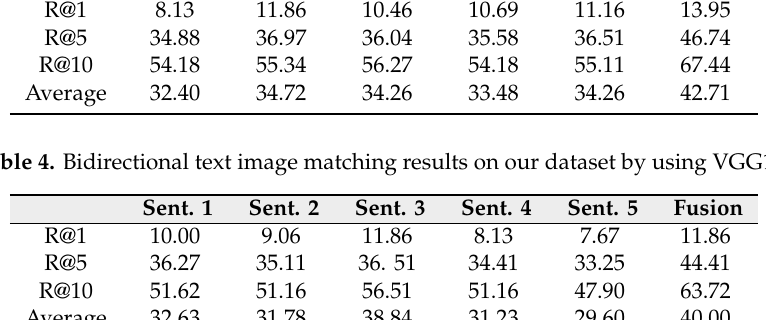
Table 3. Bidirectional text image matching results on our dataset by using Inception_v3. Table 1. Bidirectional text image matching results on our dataset by using EfficientNet-B2. Sent. 1 Sent. 2 Sent. 3 Sent. 4 Sent. 5 Sent. 1 Sent. 2 Sent. 3 Sent. 4 Sent. 5 Fusion